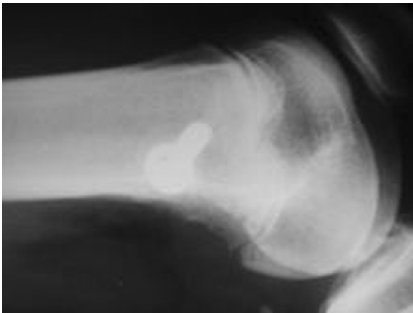
Figure 4 - The screw in its place of attachment.